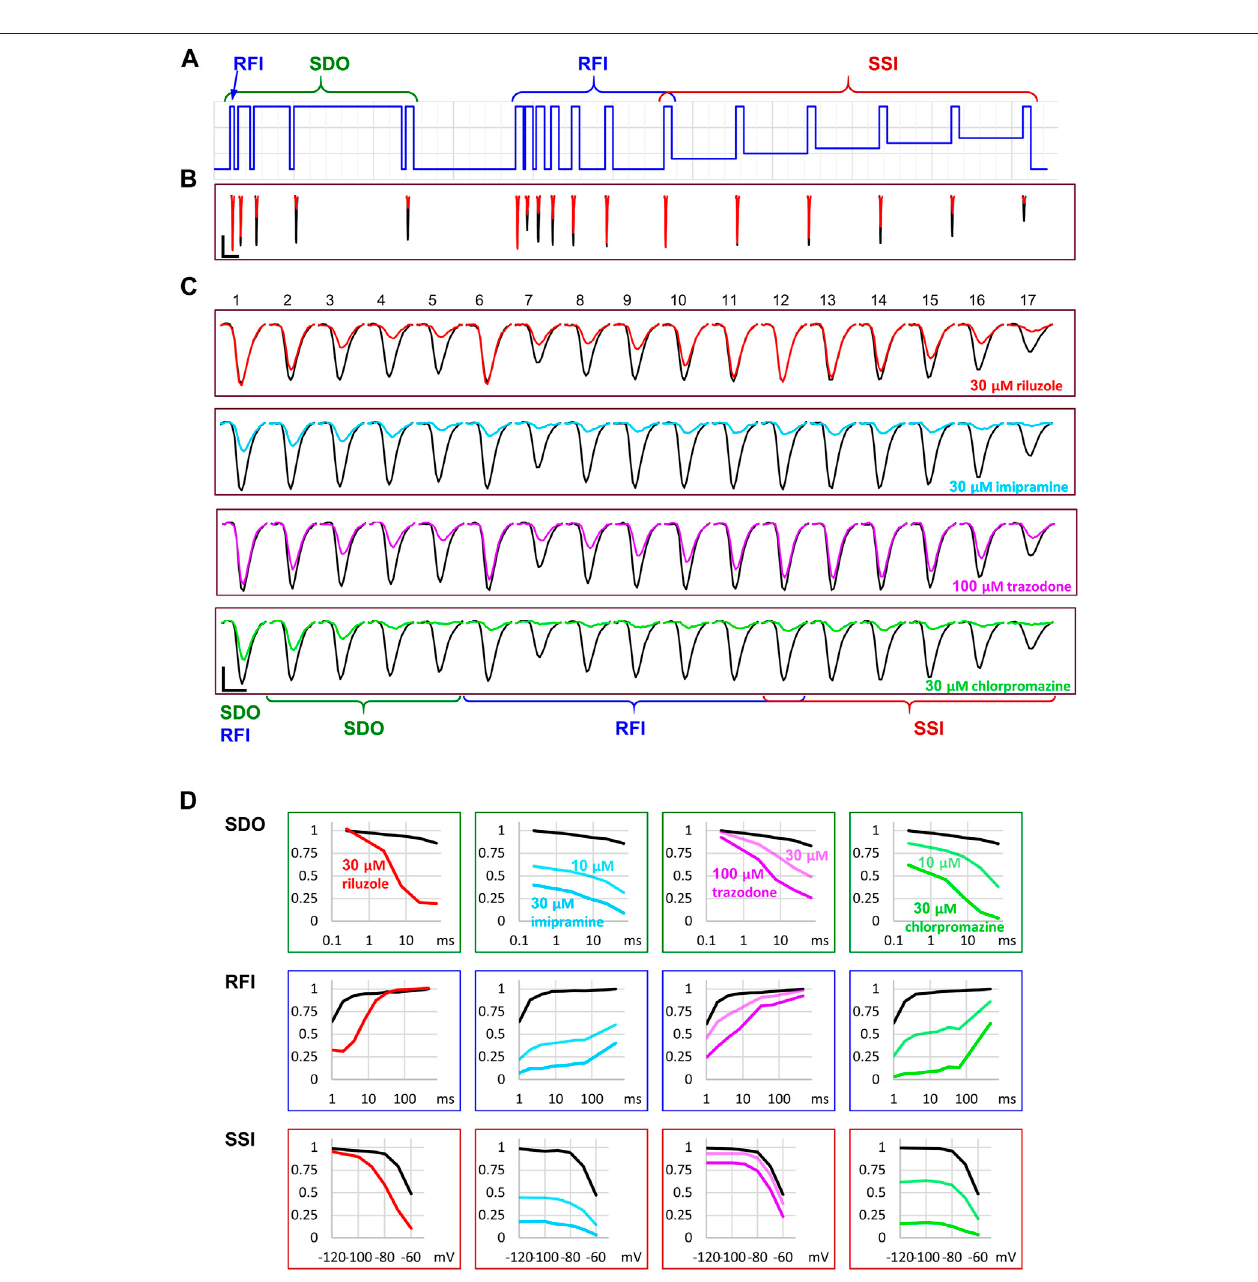
FIGURE4| ReconstructionofSDO,RFI,andSSIplotsfromthecurrentamplitudeplots. (A) Thevoltageprotocol(forreference). (B) Evokedcurrentsincontrol,and in the presence of 30 µM riluzole, shown on the same time scale as the scheme of the protocol. Note the difference in the potency of riluzole between subsequent depolarizations.Scalebars:1 nA,10 ms. (C) Evokedcurrentsonanexpandedtimescaleforvisibility,before,andduringtheperfusionofriluzole,imipramine,trazodone, and chlorpromazine. Scale bars: 1 nA, 1 ms. (D) Reconstruction of SDO , RFI , and SSI plots before, and during the perfusion of the indicated compounds.